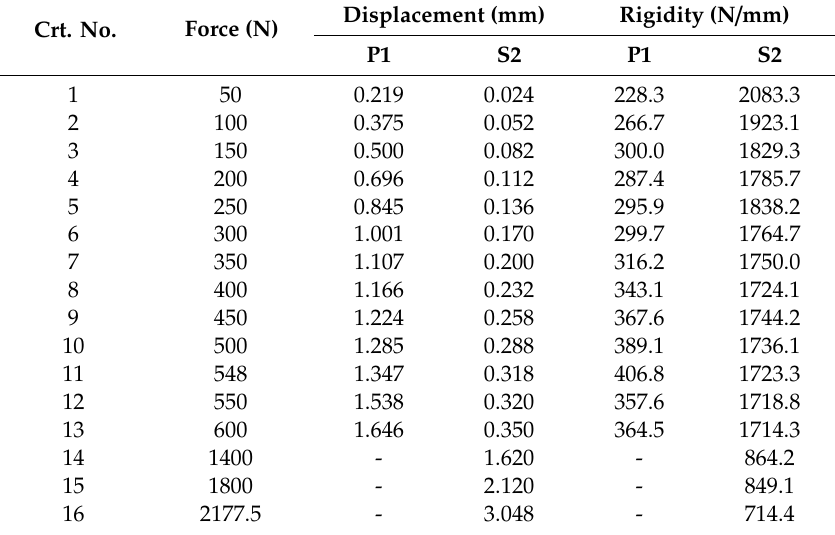
Table 2. Static testing for P1 and S2 implants.